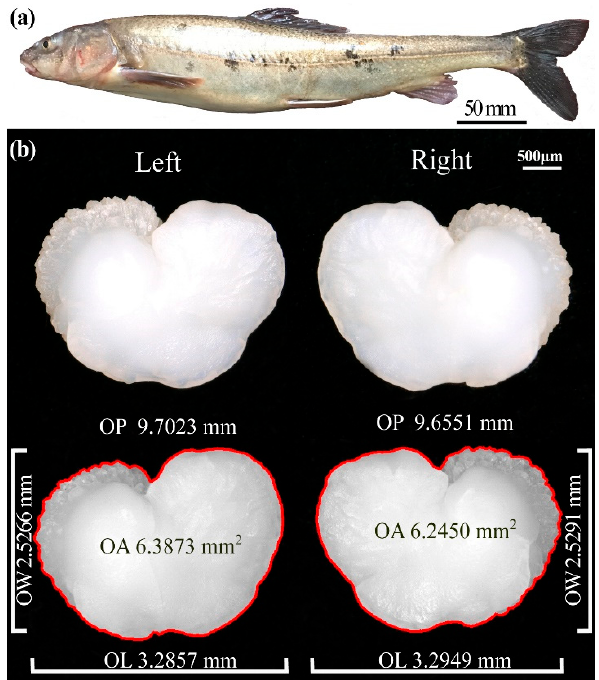
Figure 2. ( a ) Representative Schizopygopsis thermalis specimen; ( b ) three-dimensional structure of the left and right otoliths; red outlines indicate the two-dimensional contour of otoliths. OL: otolith length; OW: otolith width; OA: otolith area; OP: otolith perimeter.